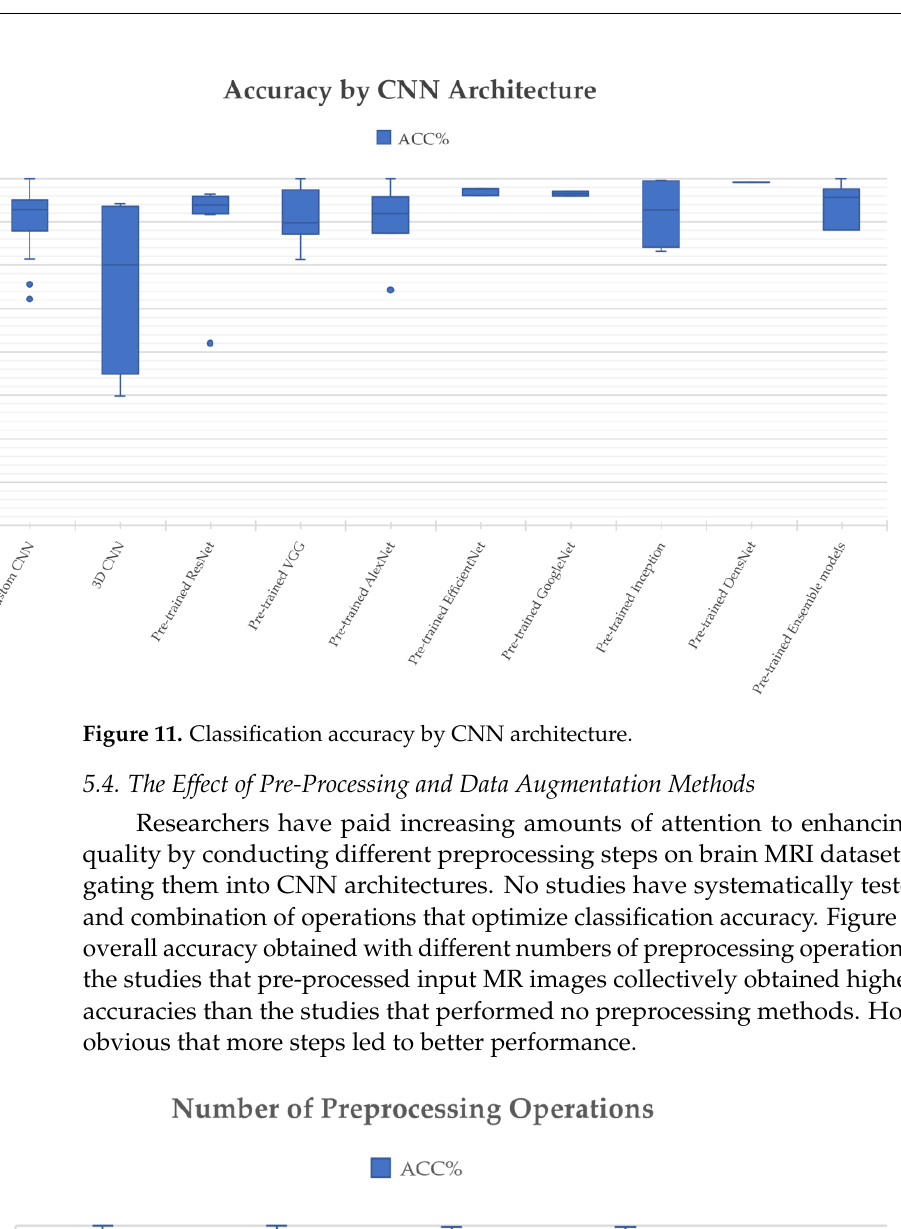
Figure 13. Classification accuracy by number of data augmentation operations. The accuracy data do not support the use of any single data augmentation method. It is interesting to ask whether data augmentation techniques were implemented specifi- cally in those studies that lacked training data. However, on average, there is little differ- ence between the 59 studies including or the 27 omitting a data augmentation step. On average, the former included 233 cases or 4743 images, and the latter included 269 cases or 7517 images. Curiously, the number of studies employing data augmentation has fallen as a proportion among those published in 2022, both compared to the total and compared to those using pre-processing methods. Figure 14 indicates the cumulative impact of factors that are not fully reported or considered in the studies reported in Table 4. Articles with multiple analyses for which factors differed were scored 1 (i.e., missing). Data are derived from Table 4, with the